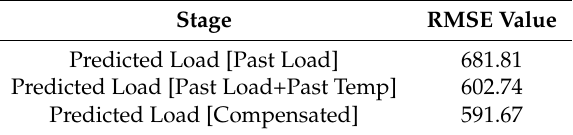
Figure 10. Load power forecast by the proposed method using summer data set. Table 6. Root mean square error (RMSE) value for summer data.